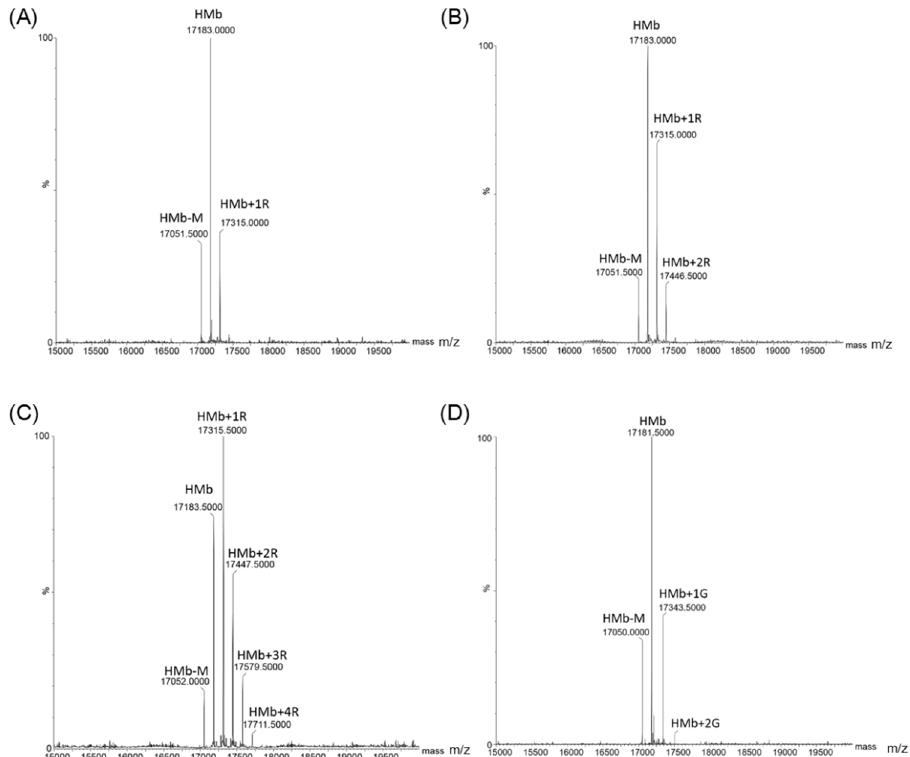
Figure 2. ESI-MS spectra of the HMb after reacting with D -ribose for 1 h ( A ), 2 h ( B ), and 4 h ( C ), respectively. The spectrum of HMb after reacting with D -glucose for 24 h ( D ) was shown for